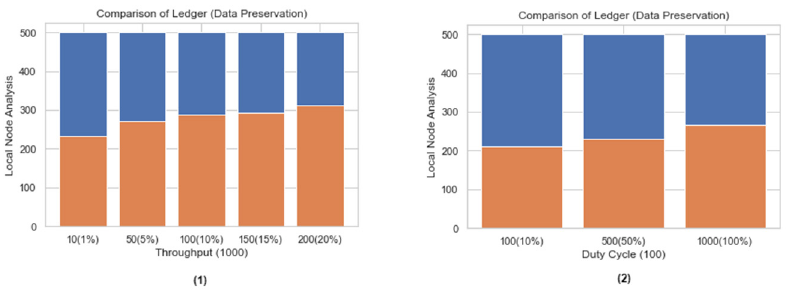
Figure 7. Comparison of Ledger Preservation or Data Storage: ( 1 ) the calculation of Throughput, and ( 2 ) the calculation of Duty Cycle.